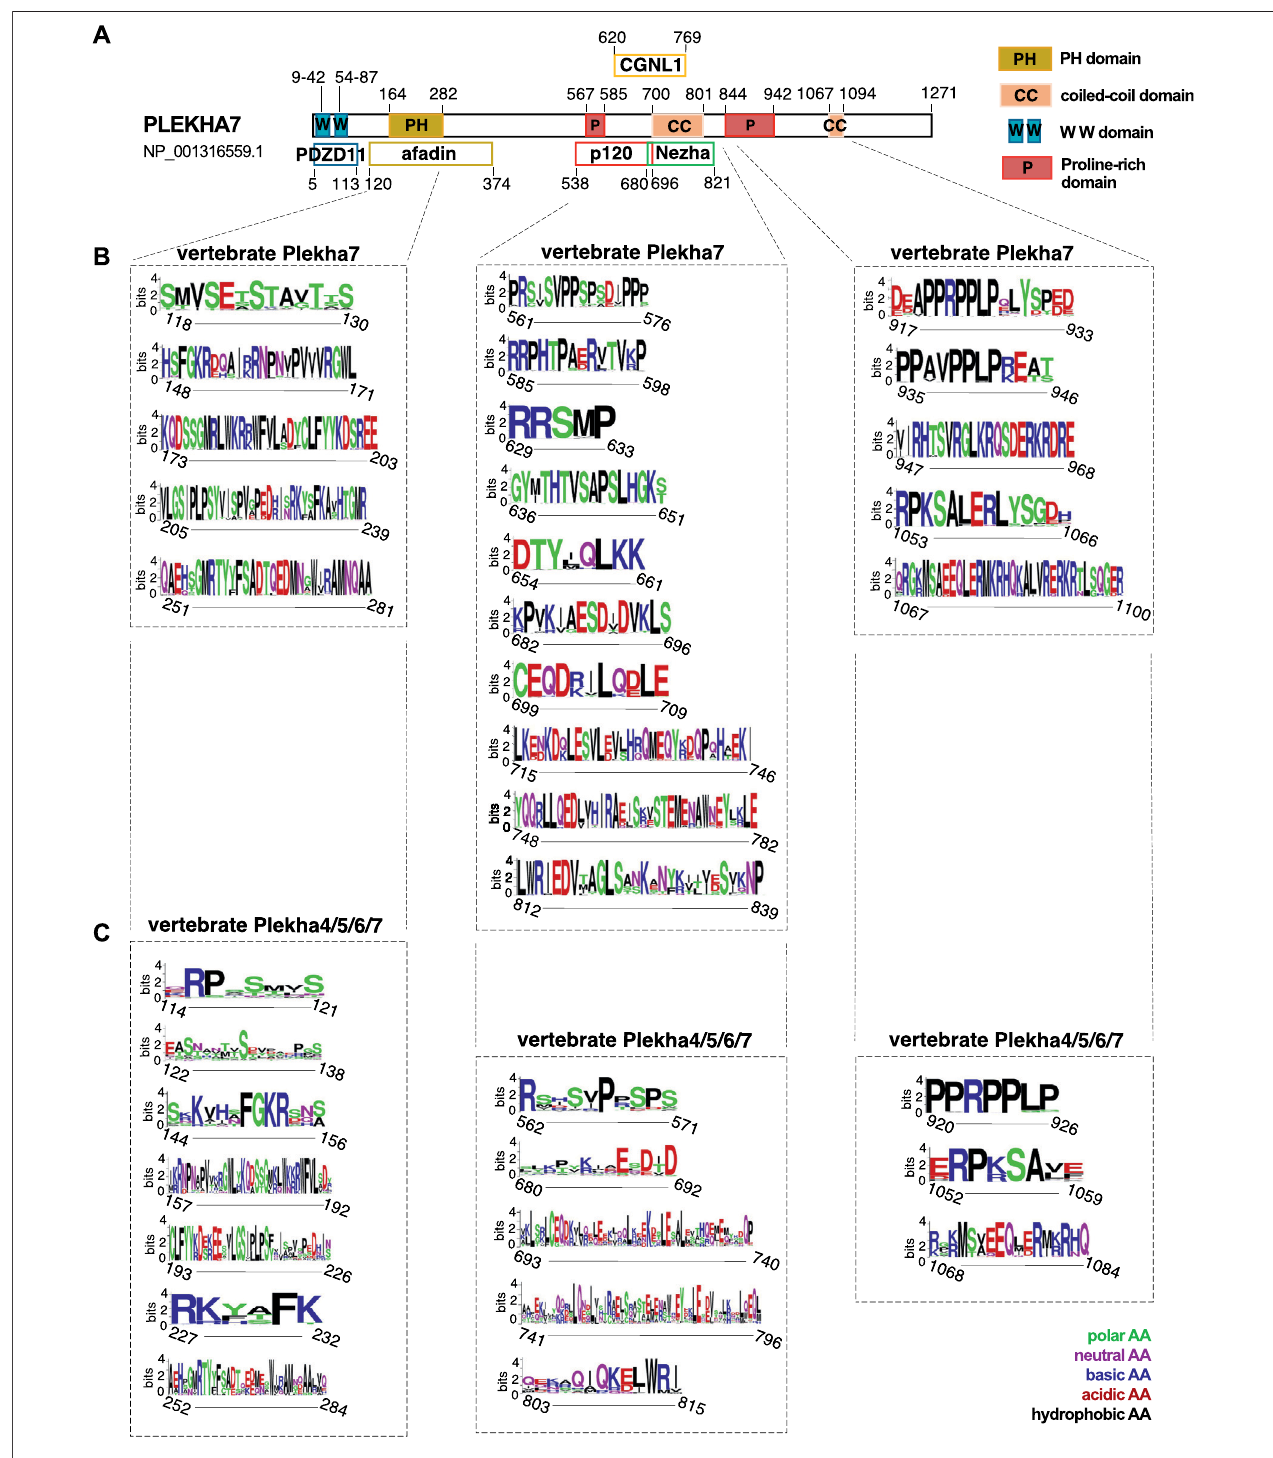
FIGURE 5 | Vertebrate Plekha4/5/6/7 protein alignments reveal conserved domains. (A) Schematic representation of the domain structure of the human PLEKHA7, based on NCBI ’ s conserved domain database (CDD) and published work; key is shown on the top right. (B,C) Domain and sequence conservation of Plekha7 and Plekha4/5/6/7 proteins across vertebrates. Amino acid conservation was determined through WebLogo analysis of the respected vertebrate Plekha7 and Plekha4/5/6/7 multiplesequencealignmentsused forthephylogeneticanalysesof Figure2B and Supplementary FigureS2 .Thetopconserved sequences are shown, as identi fi ed by the WebLogo bit scores. Conserved sequences are grouped based on their alignment to the PH/afadin, p120/Nezha/CGNL1, and C-terminal domains of the human PLEKHA7, as indicated by dotted lines and boxes. Numbers on the x axis under each sequence logo correspond to the amino acid positions of